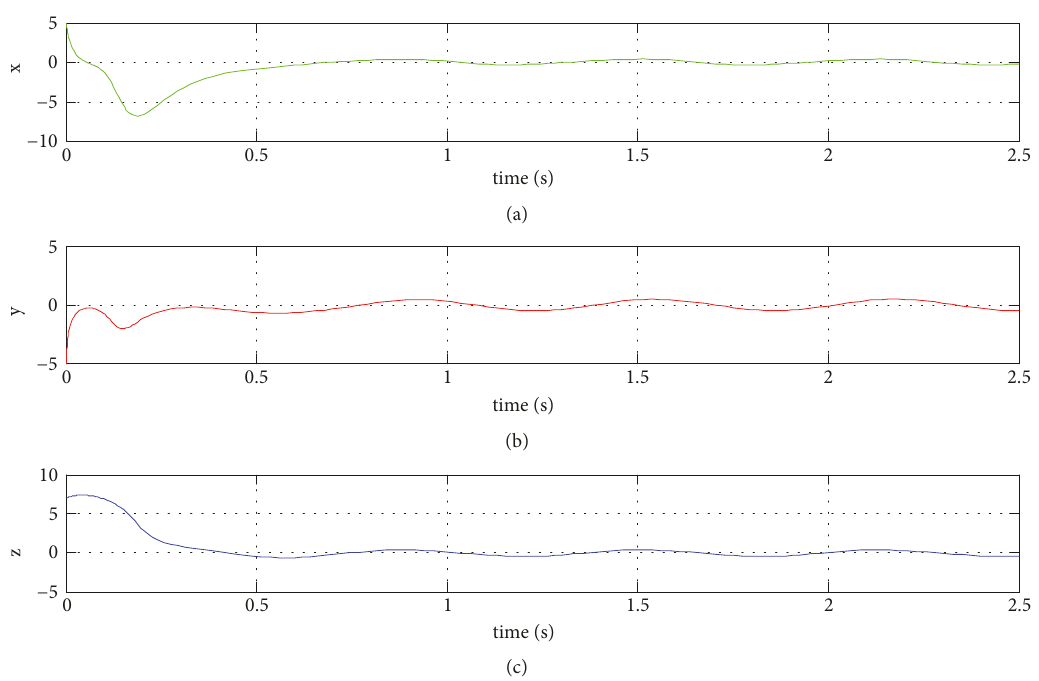
Figure 5: Application of the control law (5) for adaptive stabilization of nonideal Zhang system (25): (a) state 𝑥 , (b) state 𝑦 , and (c) state